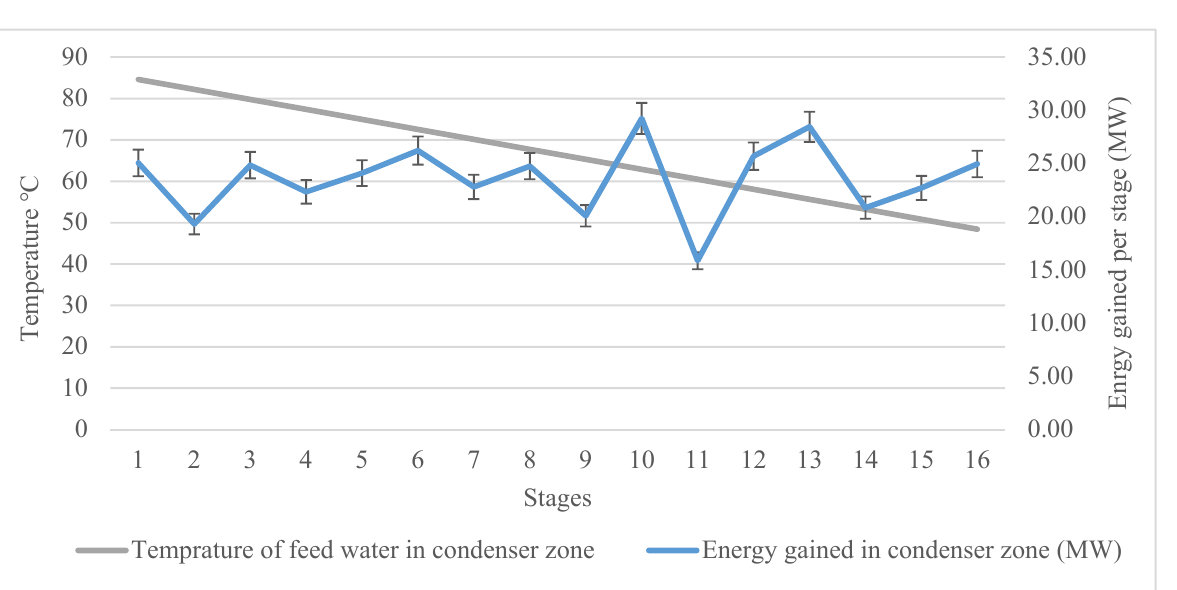
Figure 9. Thermal energy harvested in the condenser zone and the temperature increment of the feed water.